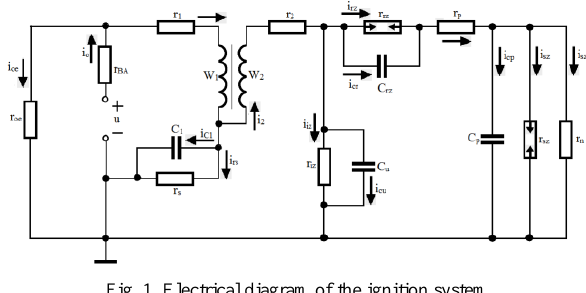
Fig. 1. Electrical diagram of the ignition system